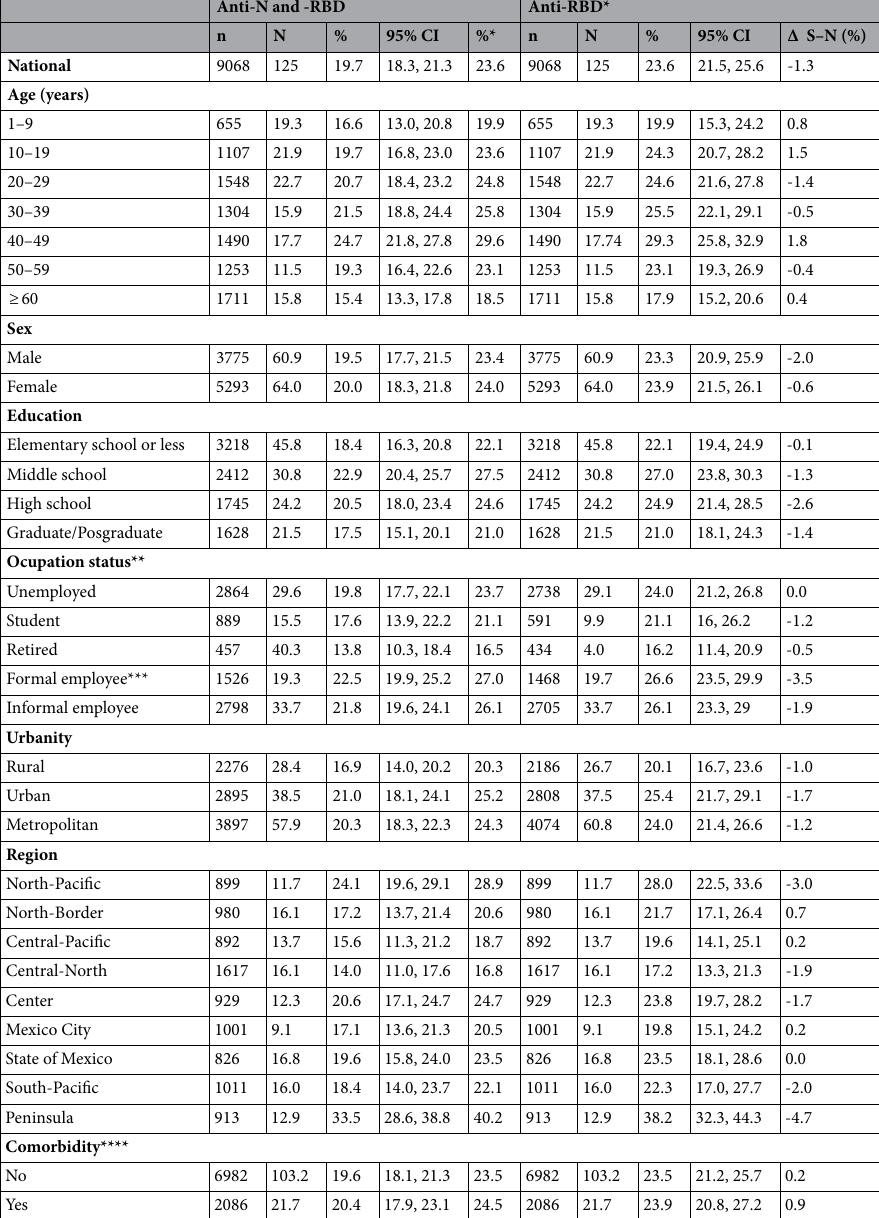
Table 2. Seroprevalence (%) of anti SARS-CoV-2 IgG in México according to sociodemographic characteristics. *Adjusted by sensitivity and specificity for Anti-RBD (Table 1) and combined N and RBD. **15 years or more. ***If you are an employee with access to social services or private medical insurance. ****Includes diabetes, hypertension, obesity, cardiovascular disease, chronic obstructive pulmonary disease, HIV,